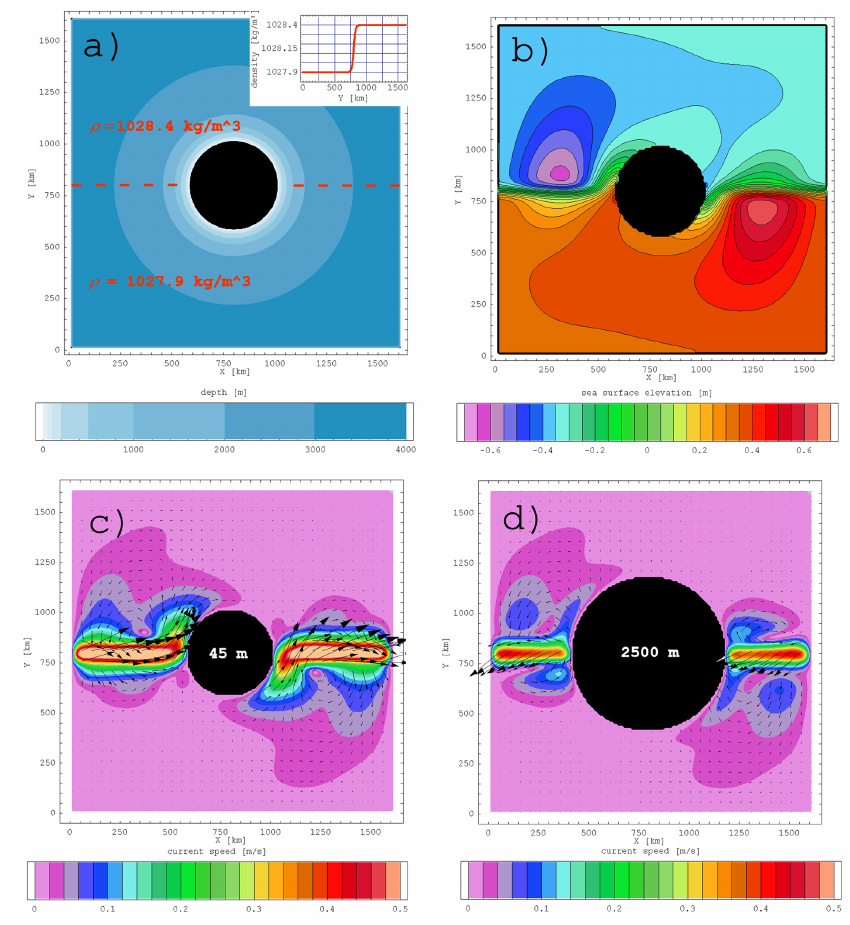
Fig. 17. Setup and results of the NIIC/SIC forcing experiment. (a) Topography and prescribed stationary density field, (b) stationary sea surface elevation after the spin-up, (c) stationary flow field at the depth of 45m, (d) stationary flow field at the depth of